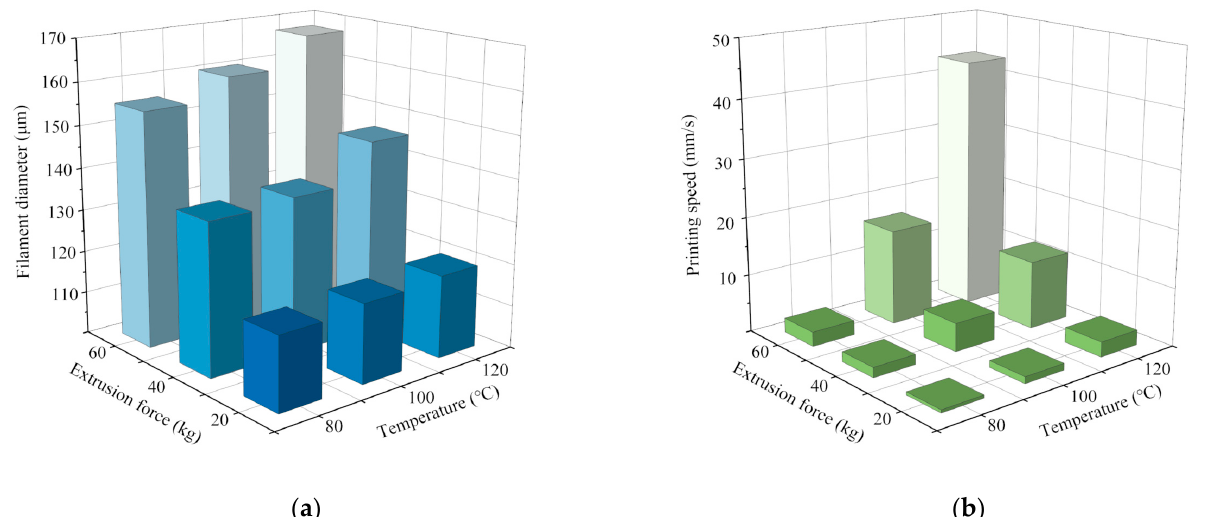
Figure 5. Influence of temperature on the extrusion process: ( a ) filament diameters of PLCL with varying extrusion forces and temperatures; ( b ) print speed of filaments with varying extrusion forces and temperatures.